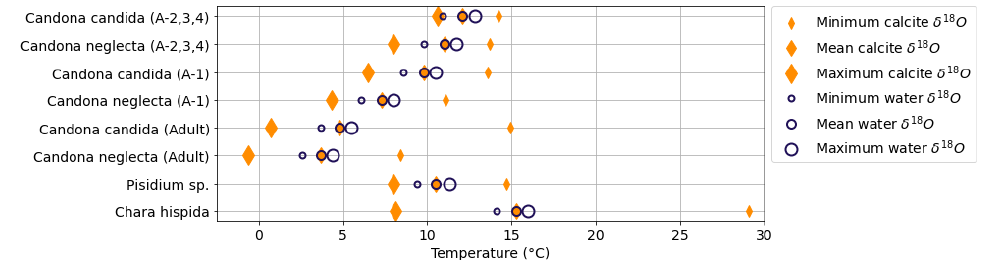
Figure 10. Theoretical temperature calculated from water and carbonate δ 18 O, assuming the carbonate was precipitated in isotopic equilib- rium with the water (according to Kim and O’Neil, 1997). Temperatures are calculated using the mean water δ 18 O and the range of measured carbonate δ 18 O values (minimum, mean and maximum) for each species and instar (orange diamonds), as well as using the mean carbonate δ 18 O of each species and instar and the range of observed water δ 18 O values (dark blue circles). The measured carbonate δ 18 O values have been corrected for known vital